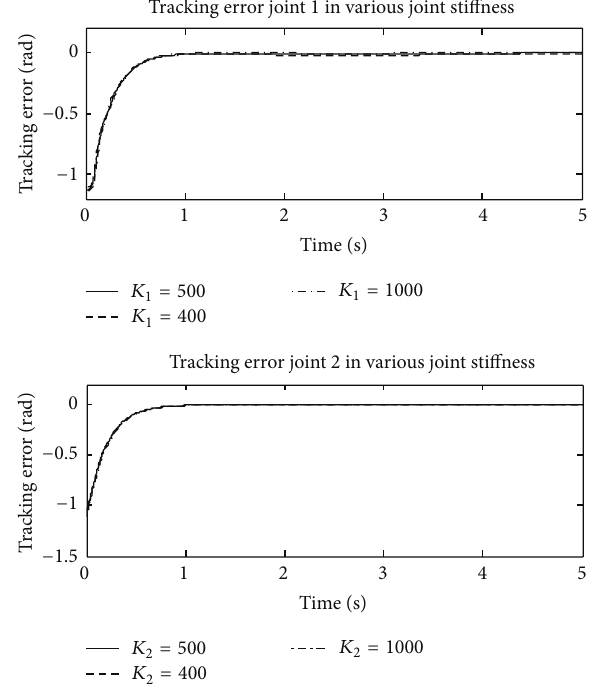
Figure 7: Tracking error in various values of joint stiffness.